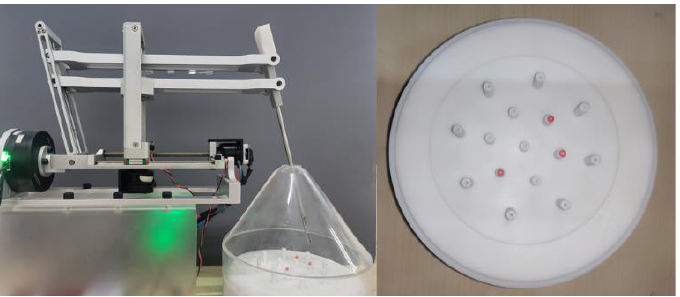
Figure 14. The experimental setup of the robotic arm gripping and handling.